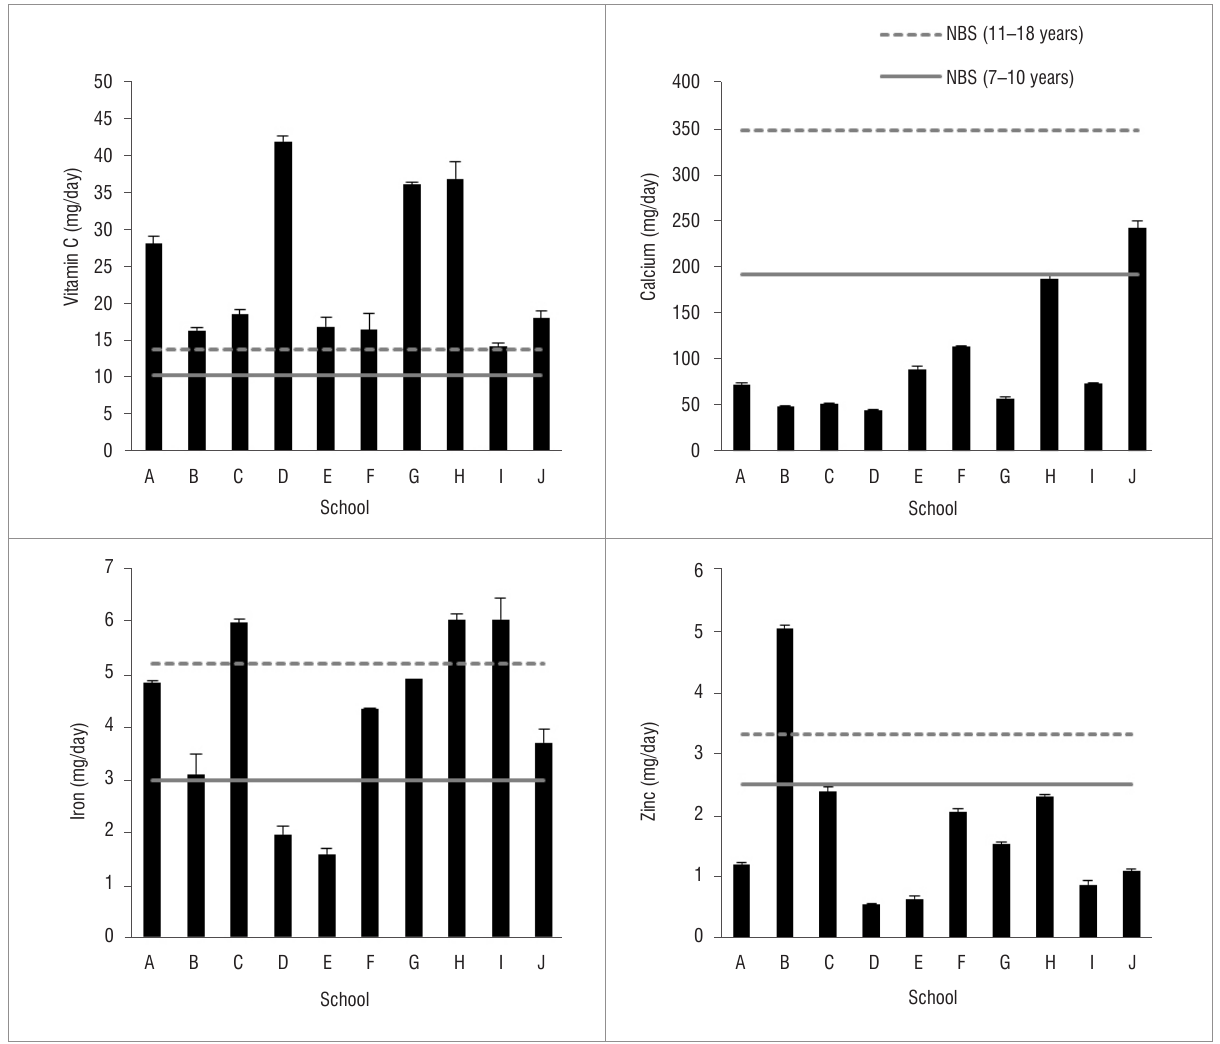
Each data point represents triplicate values. The standard deviation is represented by the error bar. NBS, nutrient-based standards. Meals sampled from Schools A to J: A – maize porridge and cabbage with potatoes; B – maize porridge and soup with beans and cabbage; C – maize rice and soya mince stew with potatoes and carrots; D – maize rice and beef stew with carrots and potatoes; E – rice and cabbage with potatoes and carrots; F – maize porridge and cabbage with tinned fish; G – samp and soya mince stew with potatoes and pumpkin; H - maize porridge and milk; I – maize rice and soya mince stew with potatoes and carrots; and J – rice and tinned fish (pilchards in tomato sauce) stew. Onions, cooking oil, salt and spices were included during the preparation of all protein portions of meals, except at School H. Figure 2: Mean micronutrient values of meals sampled at various schools participating in the National School Nutrition